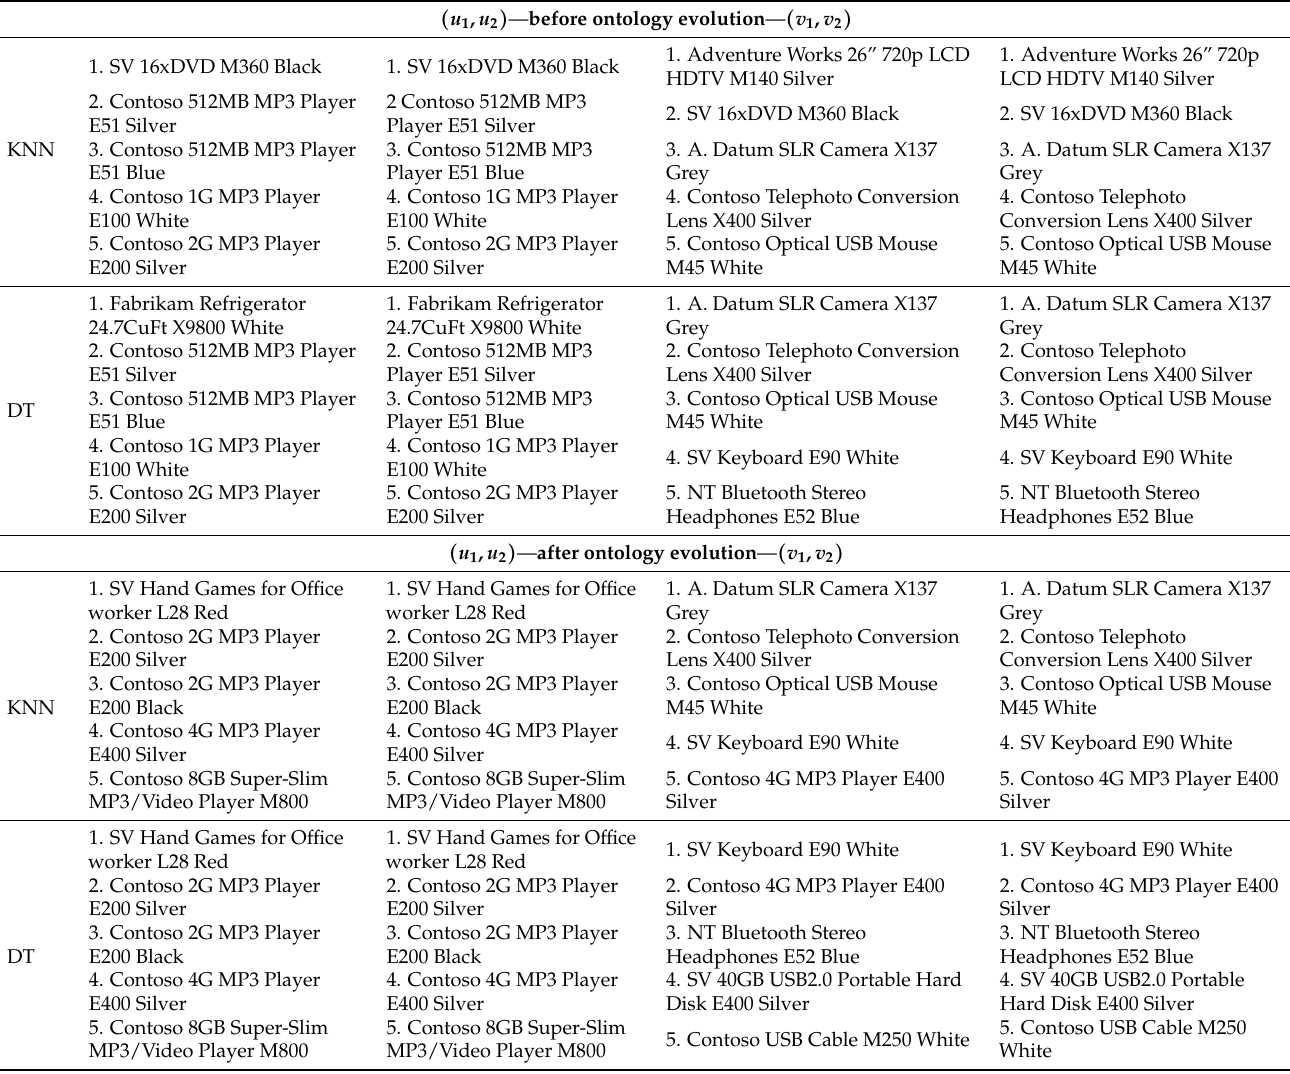
Table 8. Top-five recommendation for two pairs of aligned users using the KNN and DT